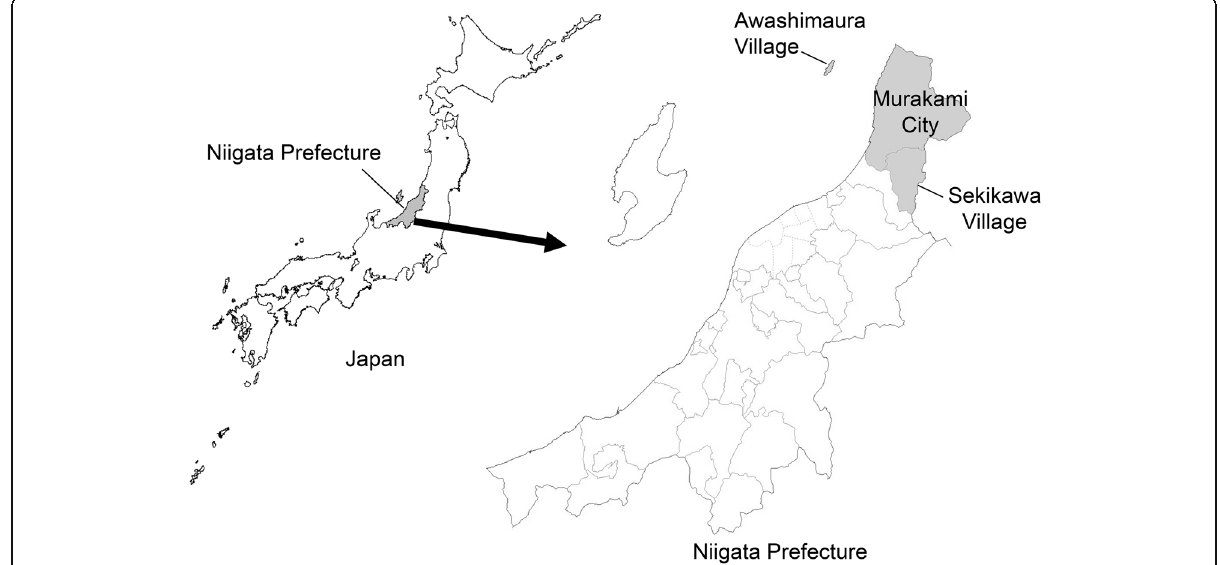
Fig. 1 Location of Murakami City, Sekikawa Village, and Awashimaura Village in Niigata Prefecture,